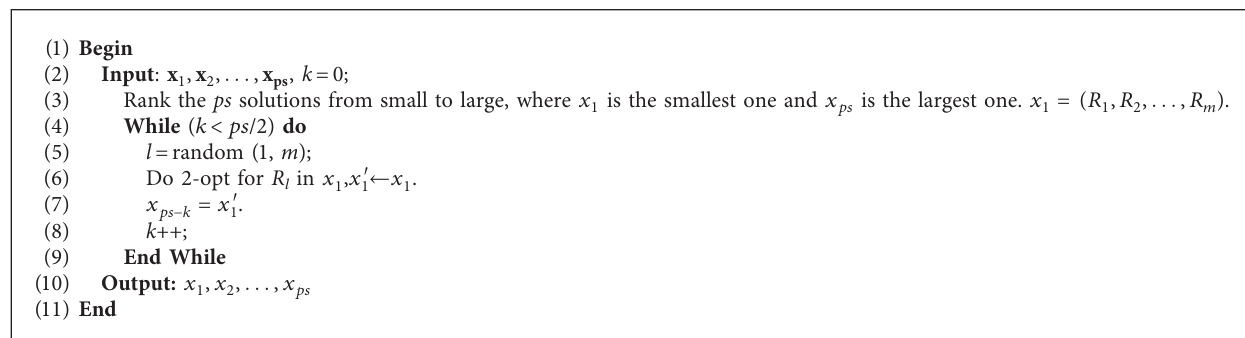
A LGORITHM 1: Best population immigrant